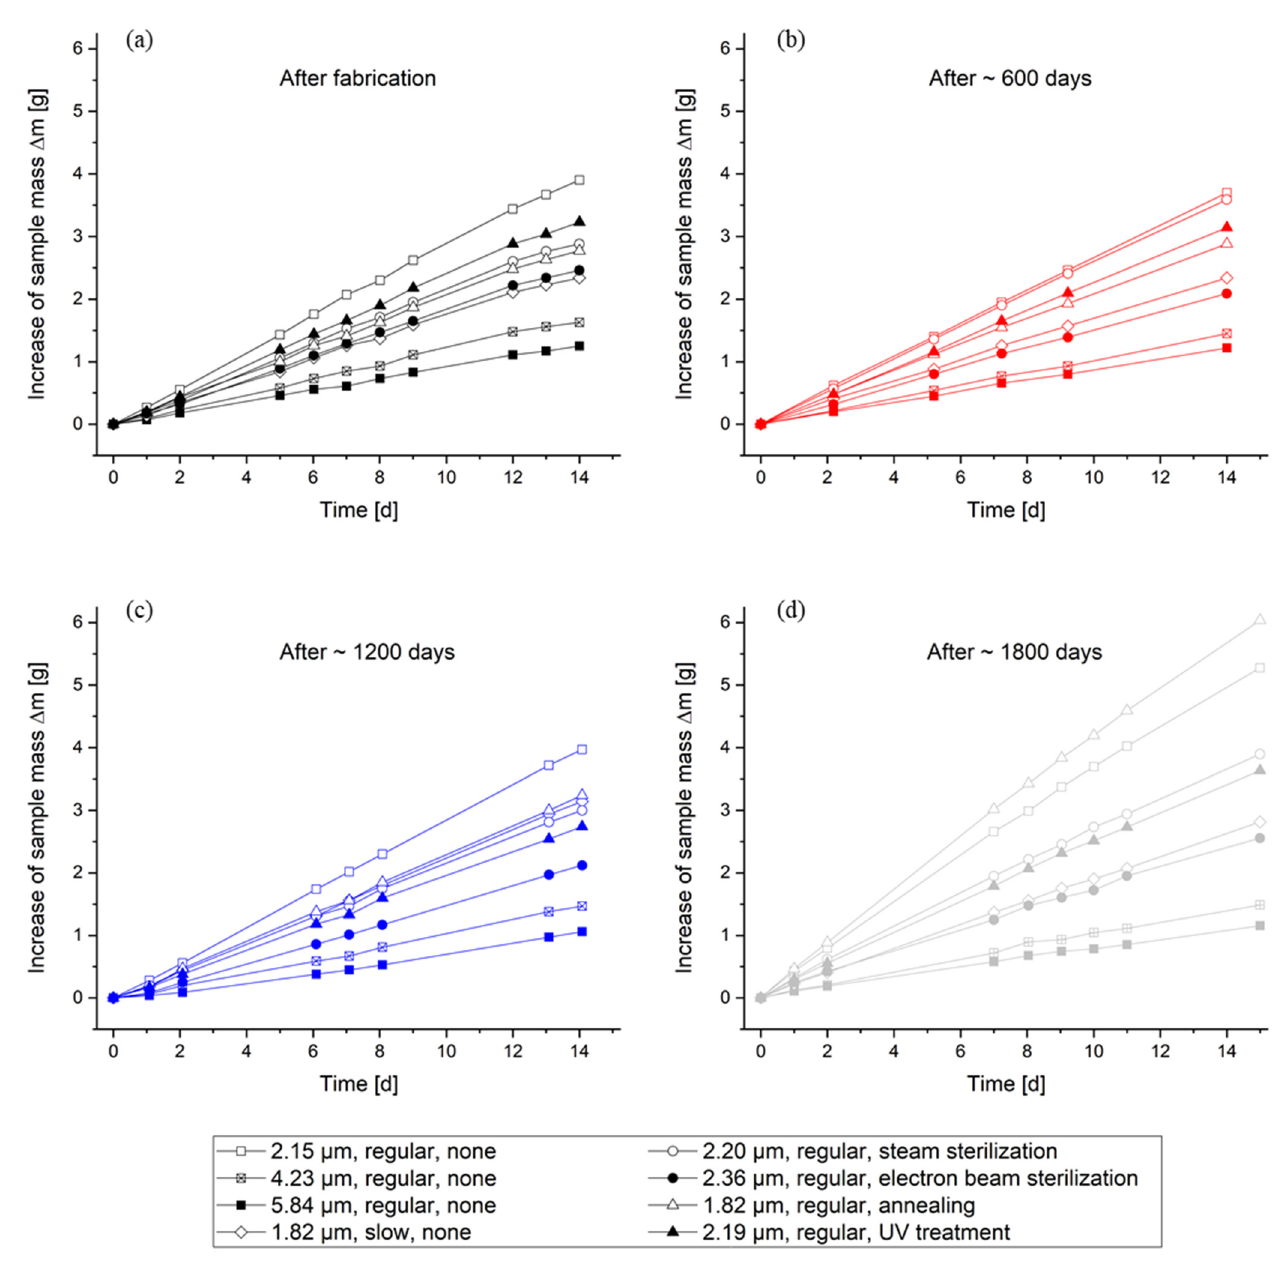
Figure A1. Time-dependent increase in the sample mass during the gravimetric determination of the WVTR according to DIN 53122 after fabrication ( a ) and non-accelerated aging of ~600 days ( b ), ~1200 days ( c ), and ~1800 days ( d ), respectively.